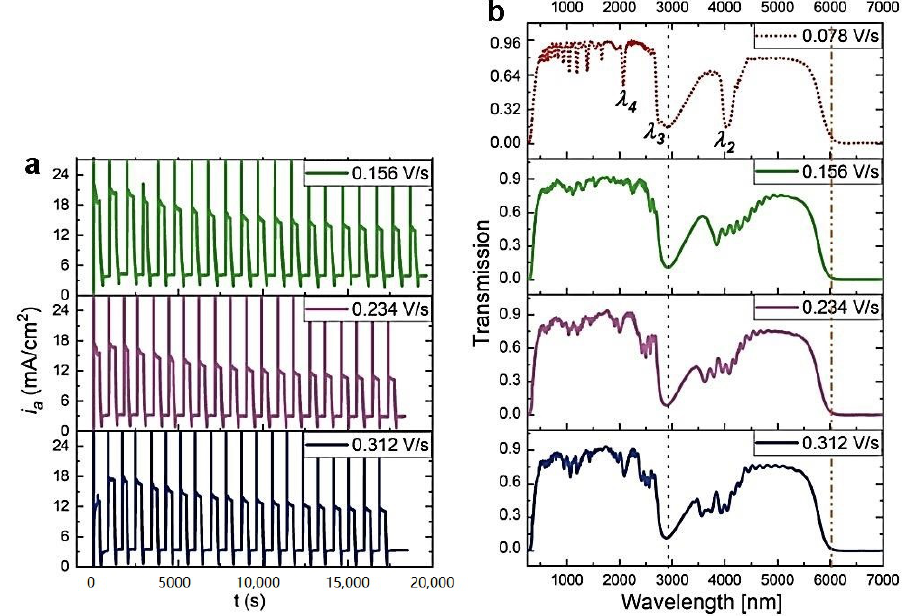
Figure 3. The i a ( t ) curves recorded during pulse anodization at 29 ◦ C (other parameters: U H = 50 V, t H = 360 s, U L = 20 V, t L = 480 s, 20 cycles) with increasing U H - > U L rate from 0.156 V / s down to 0.312 V / s ( a ), the corresponding transmission spectra ( b ). The transmission spectra of the PAA-29 ◦ C sample synthesized with the U H - > U L rate of 0.078 V / s is also shown for comparison.